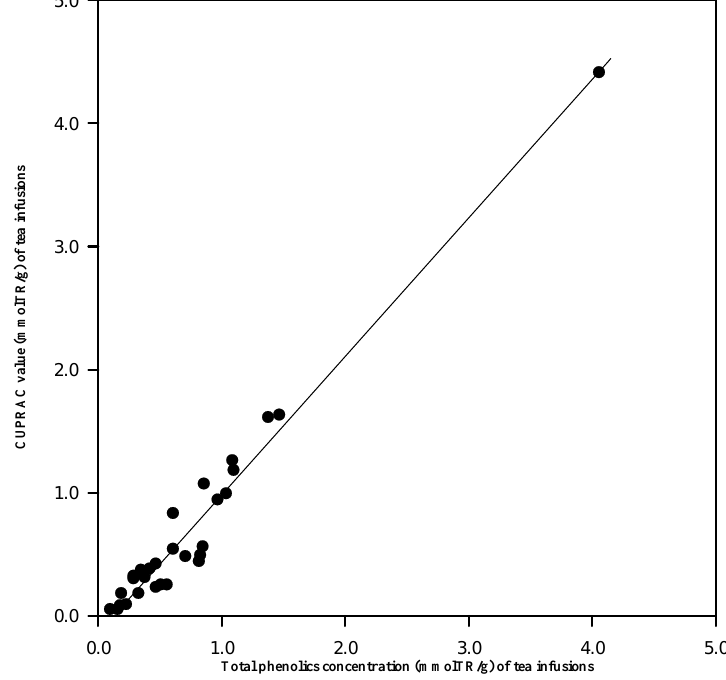
Figure 6. The correlation of CUPRAC assays results with those of Folin for herbal